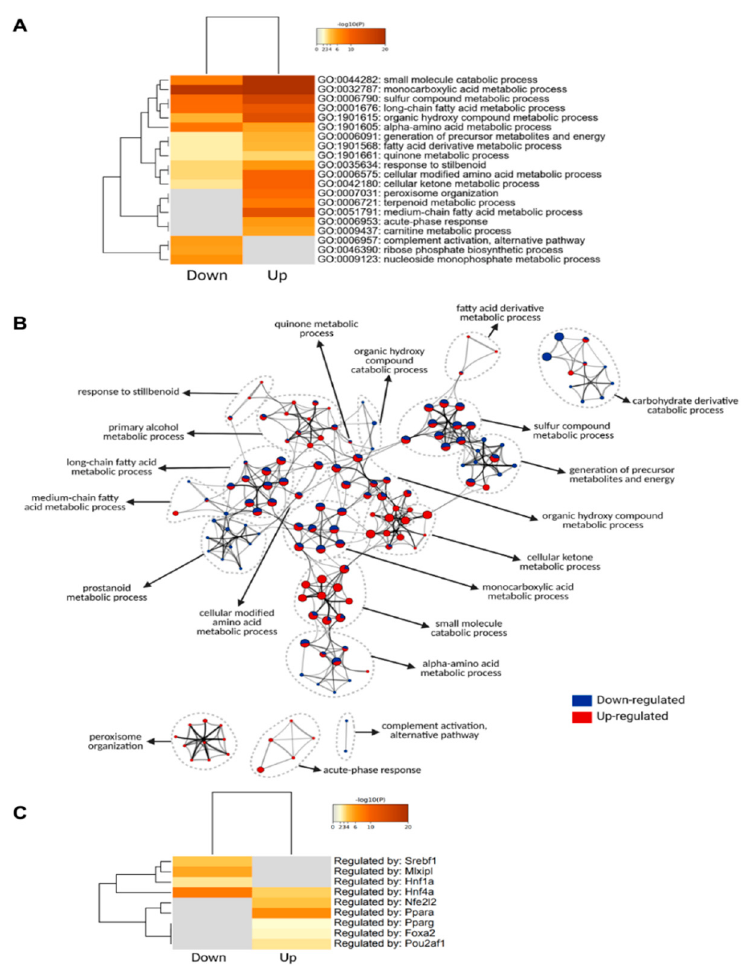
Figure 4. Gene ontology analysis of significantly regulated proteins. ( A ) Metascape enrichment analysis of statistically enriched GO Biological Process (BP) terms. The terms were selected with the best p -value within each cluster as its representative term. ( B ) Enriched clusters’ GO-BP terms in network format. Each enriched term is displayed as a circle node whose size is proportional to the number of input proteins that fall into the term. Each node is represented as a pie chart and each pie sector is proportional to the number of hits originated from either up- or downregulated proteins. ( C ) Enrichment of transcriptional regulators of significantly regulated proteins using TRRUST (transcriptional regulatory relationships unraveled by sentence-based text-mining)